Question: Sum up the contents of this chart in one sentence.
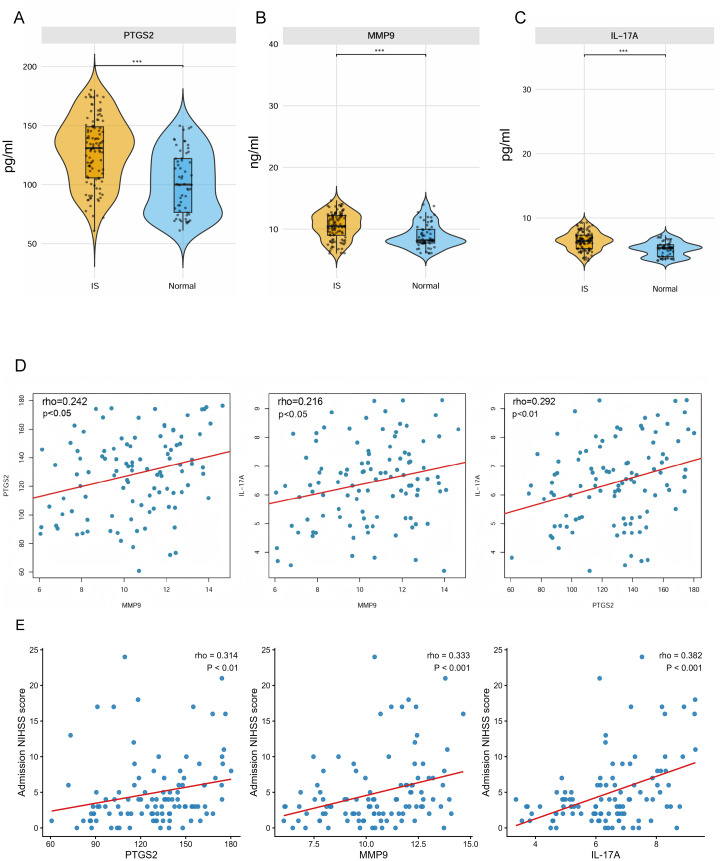
Answer: Serum IL-17A, PTGS2, and MMP9 levels in the clinical cohort and their correlations with each other and with stroke severity. (A–C) Serum IL-17A, PTGS2, and MMP9 levels were significantly higher in patients with ischemic stroke than in healthy controls. IS, ischemic stroke (n = 104); Normal, control group (n = 58). (D) Correlations among serum IL-17A, PTGS2, and MMP9 levels in the stroke group. (E) Positive correlations between serum IL-17A, PTGS2, and MMP9 levels and admission NIHSS scores in patients with ischemic stroke. Correlations were analyzed using Spearman’s rank correlation test. *P < 0.05, **P < 0.01, ***P < 0.001.